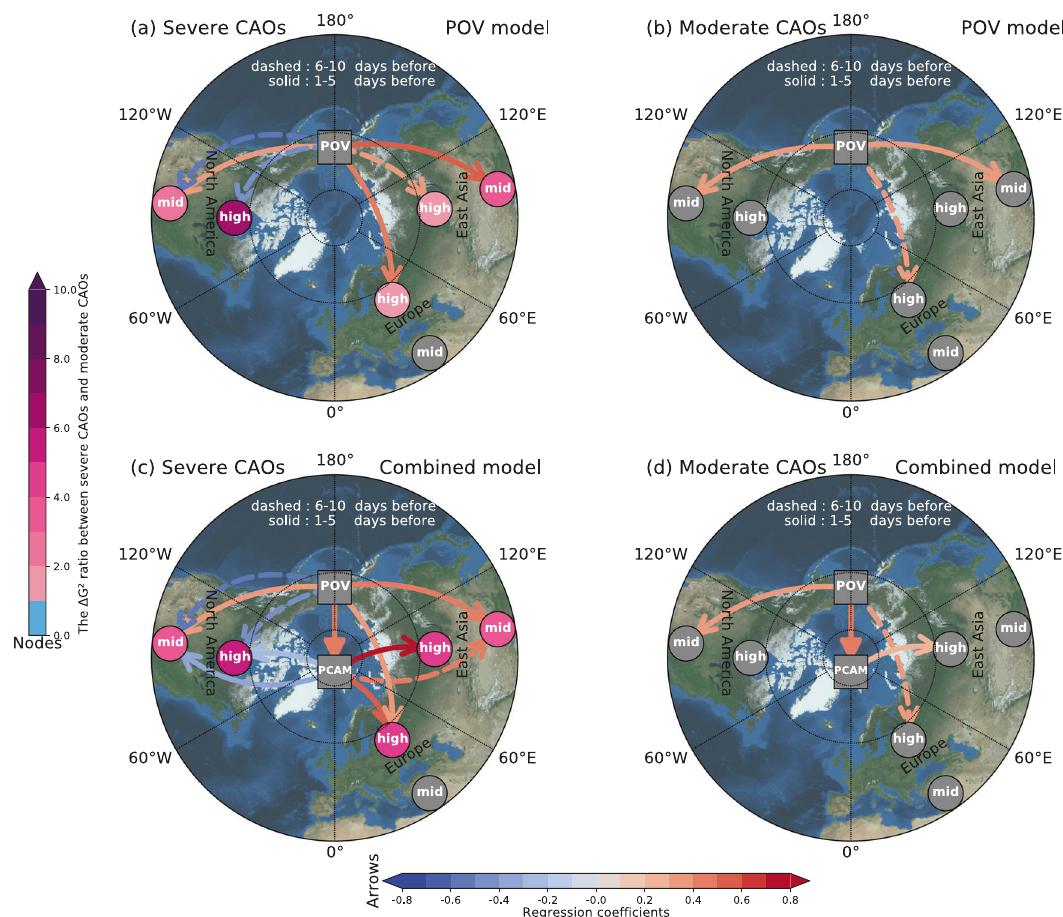
Fig. 5 Graphical representation of Granger causality using logistic regression. a The results of Granger causality analysis of severe CAOs in terms of the POV model according to the reanalysis data. b As shown in ( a ), but for moderate CAOs. c , d As shown in ( a ) and ( b ), respectively, but for the Granger causality analysis in terms of the combined model. Note that we add the signi fi cant links between the polar vortex and the cold air mass transport in ( c ) and ( d ), respectively. Circles represent the predictands, namely, the current states of CAOs at high latitudes and mid-latitudes. Squares denote predictors (e.g., POV or PCAM), namely, past states of the polar vortex and the cold air mass transport. The arrows denote the direction of the in fl uence, with dashed arrows denoting that the predictor 6 – 10 days before provides predictive information to the predictand and solid arrows for the predictor 1 – 5 days before. The arrow colors denote the logistic regression coef fi cients with only statistically signi fi cant links ( p < 0.05) being presented (the color bar on the bottom; the contour interval is 0.1). The node colors in ( a ) and ( c ) indicate the ratio between the Δ G 2 of severe CAOs and that of moderate CAOs (the color bar to the left; the contour interval is 1.0). A larger value of Δ G 2 means a better model performance. See “ Methods ” for the de fi nition of Δ G 2 . We do not color the node over mid-latitude Europe, since there is not a signi fi cant link for both severe and moderate